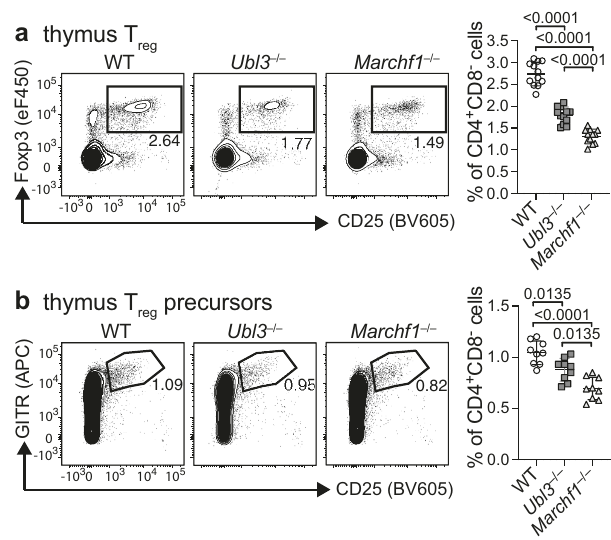
Fig. 5 UBL3 is required for normal thymic T reg development. Quanti fi cation of a Foxp3 + CD25 + T reg or b Foxp3 − CD25 + GITR + T reg precursor frequencies in thymus. Representative plots are shown on the left. Graphs on the right show pooled data from a n = 12 mice examined over four experiments and b n = 9 mice examined over three experiments, with each symbol representing an individual mouse and bars designating mean ± SD. P values shown above bars, one-way ANOVA with Bonferroni ’ s multiple comparisons